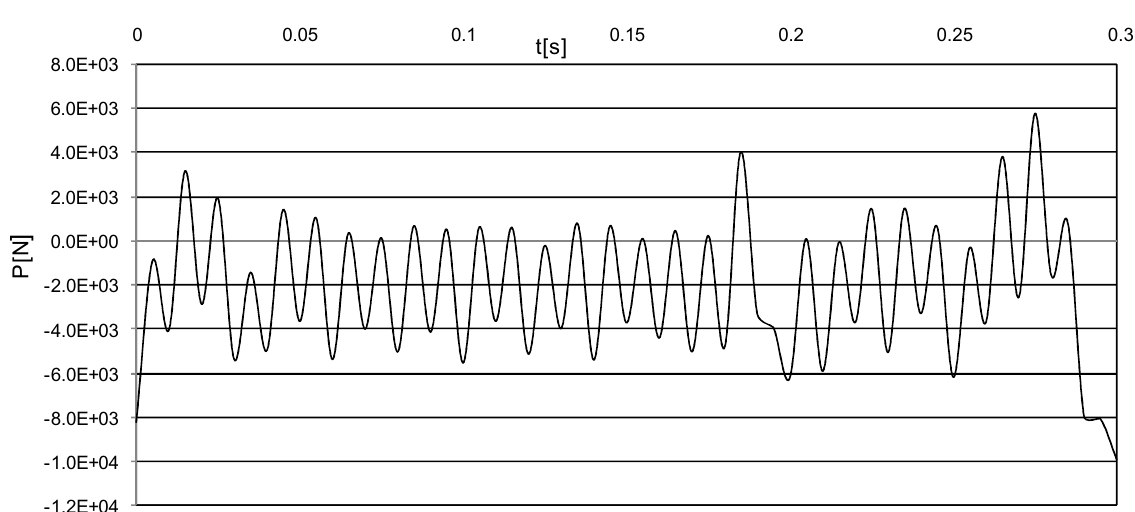
Fig. 7. Optimum control force for the limiting isolation capacity with preview